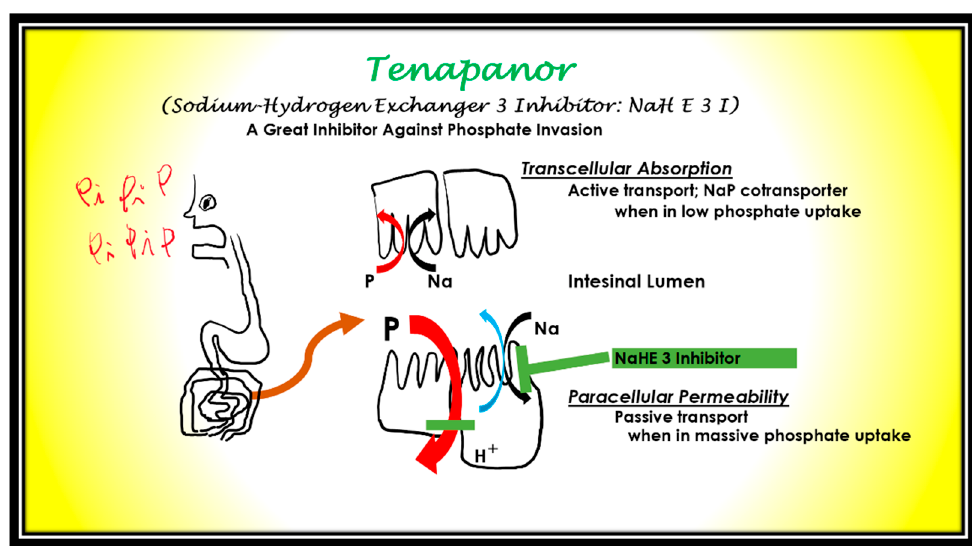
Figure 10. Methods to prevent the invading P.